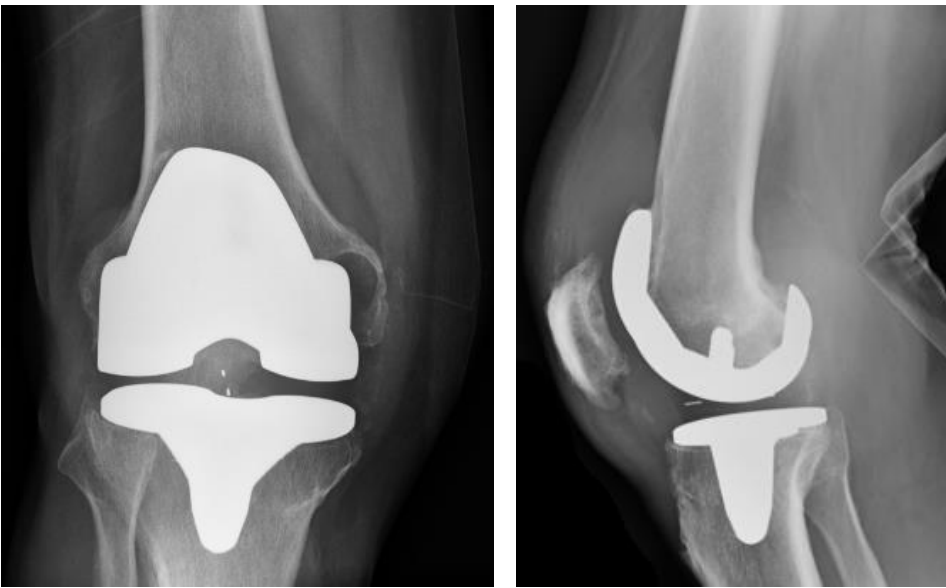
Figure 1. AP (Anteroposterior) and lateral radiographs of infected primary TKA (total knee arthro- plasty).